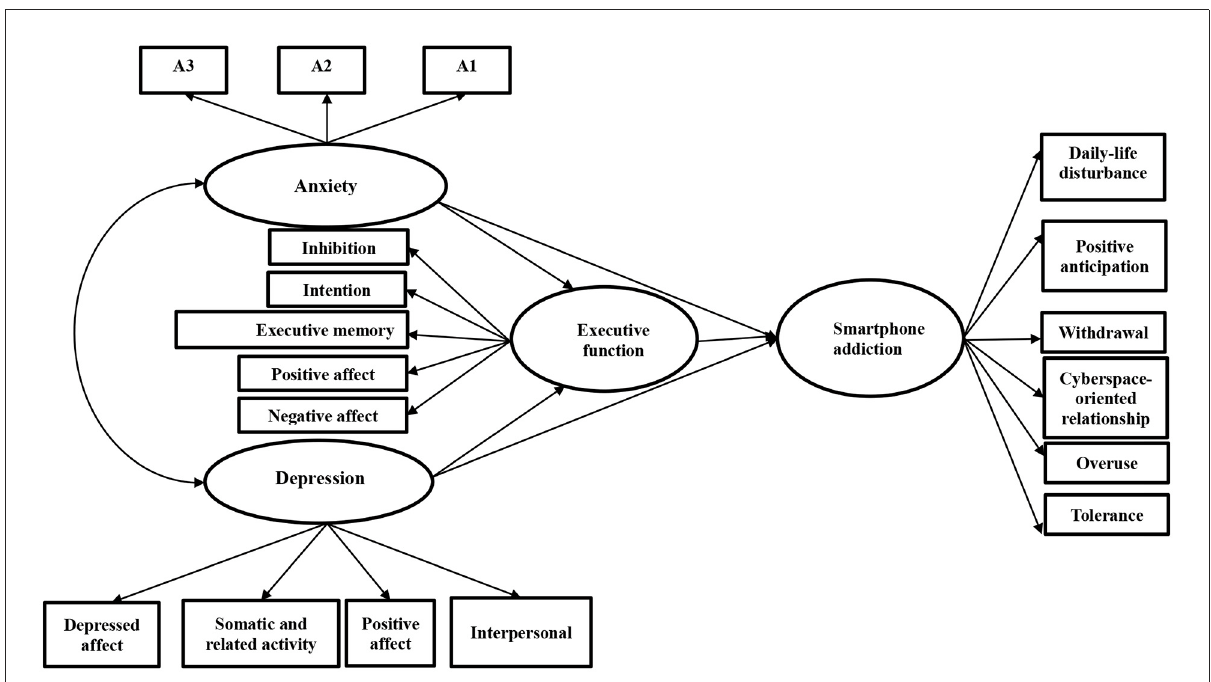
FIGURE1 Hypothetical model concerning the mediation effect of executive dysfunction in the relationships between anxiety and depression with smartphone